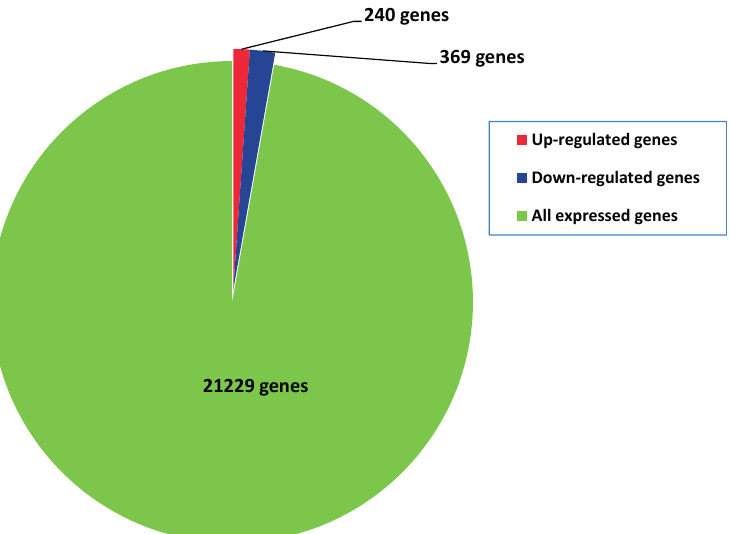
Figure 3. Number of differentially expressed genes identified between autotetraploids and diploids. The genes differentially up- and down-regulated in autotetraploids were determined comparing with corresponding samples of diploids (log 2 (RPKM autotetraploid / RPKM diploid ) ≥ 1, and probability ≥ 0.8)